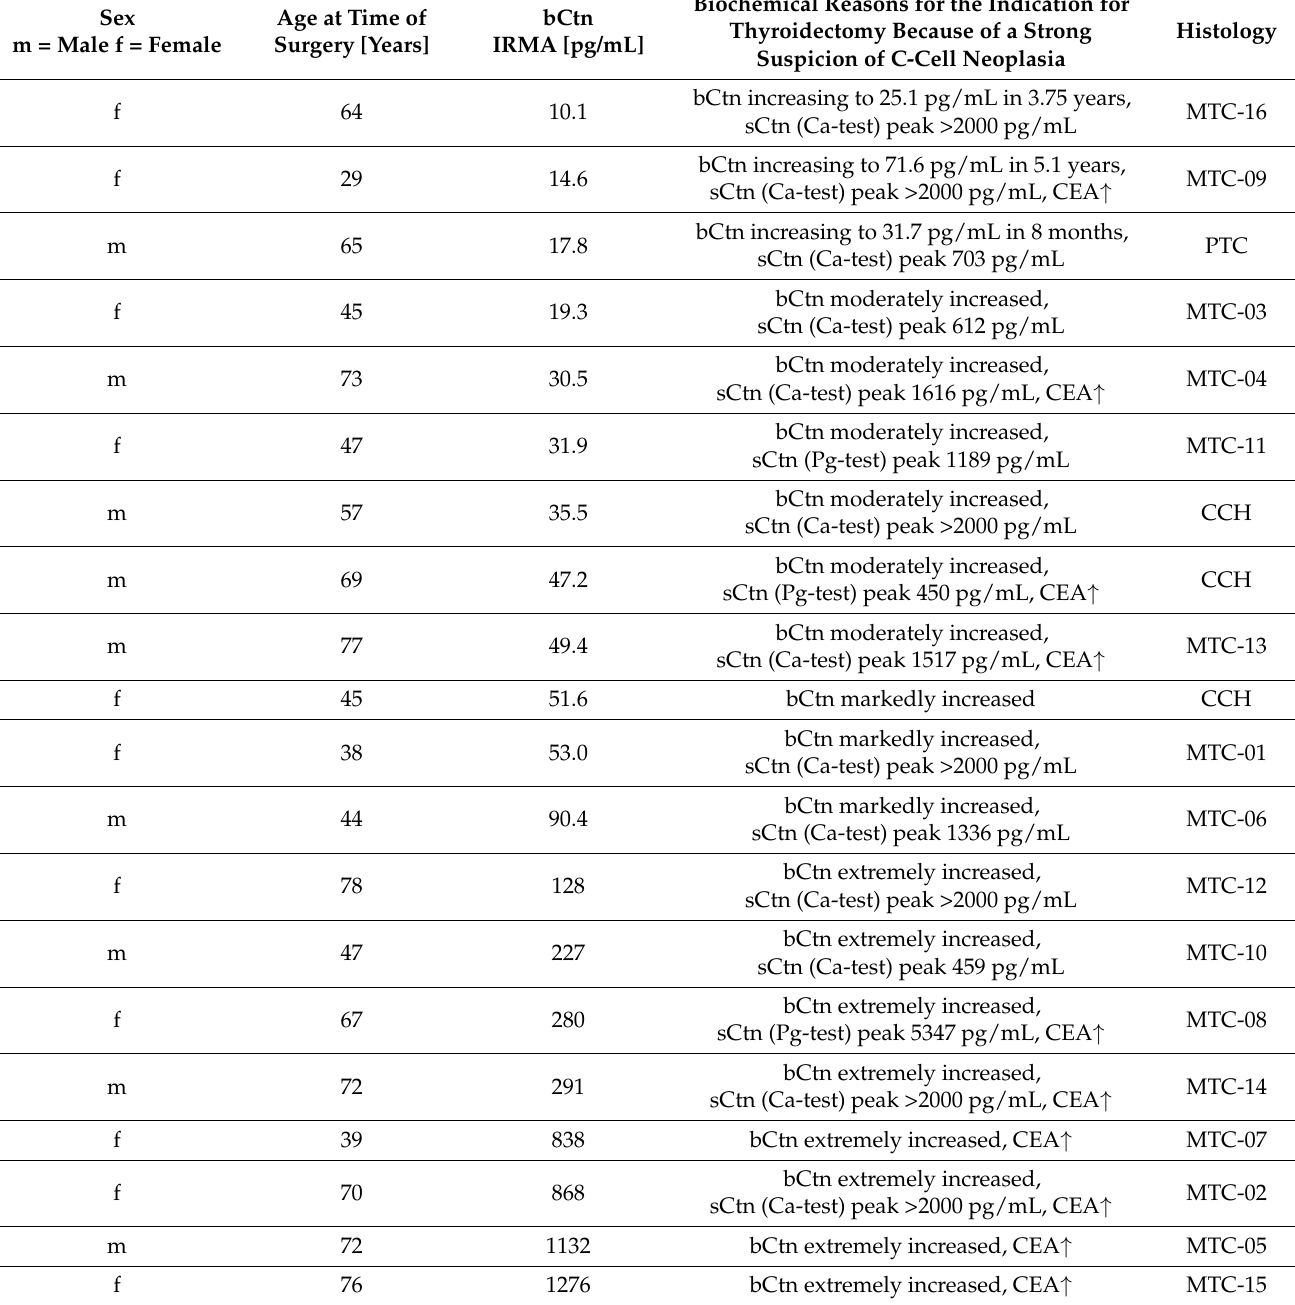
Table 1. Characteristics of all 20 patients within the screening period November 2008–November 2014 in whom, based on Ctn measurement, the indication for thyroidectomy was made due to the suspicion of C-cell neoplasia. bCtn = basal calcitonin (at the time of screening, Ctn elevations had been confirmed per a confirmation test with ICMA); sCt = stimulated calcitonin; Ca test